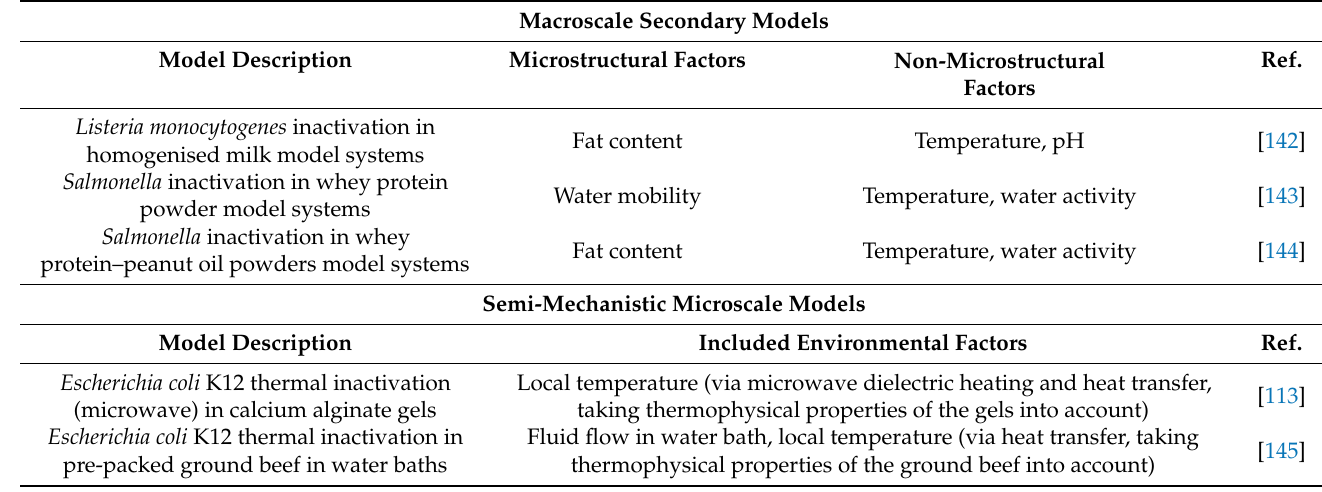
Table 3. Overview of the most relevant thermal inactivation models incorporating food